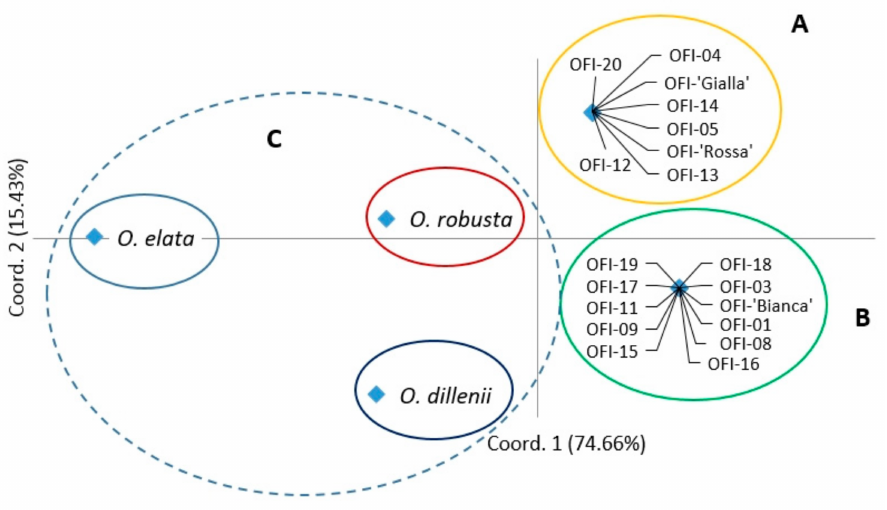
Figure 2. Principal coordinates analysis (PCoA) based on Nei’s genetic distances among the 22 Opuntia spp. populations. OFI– Opuntia ficus-indica